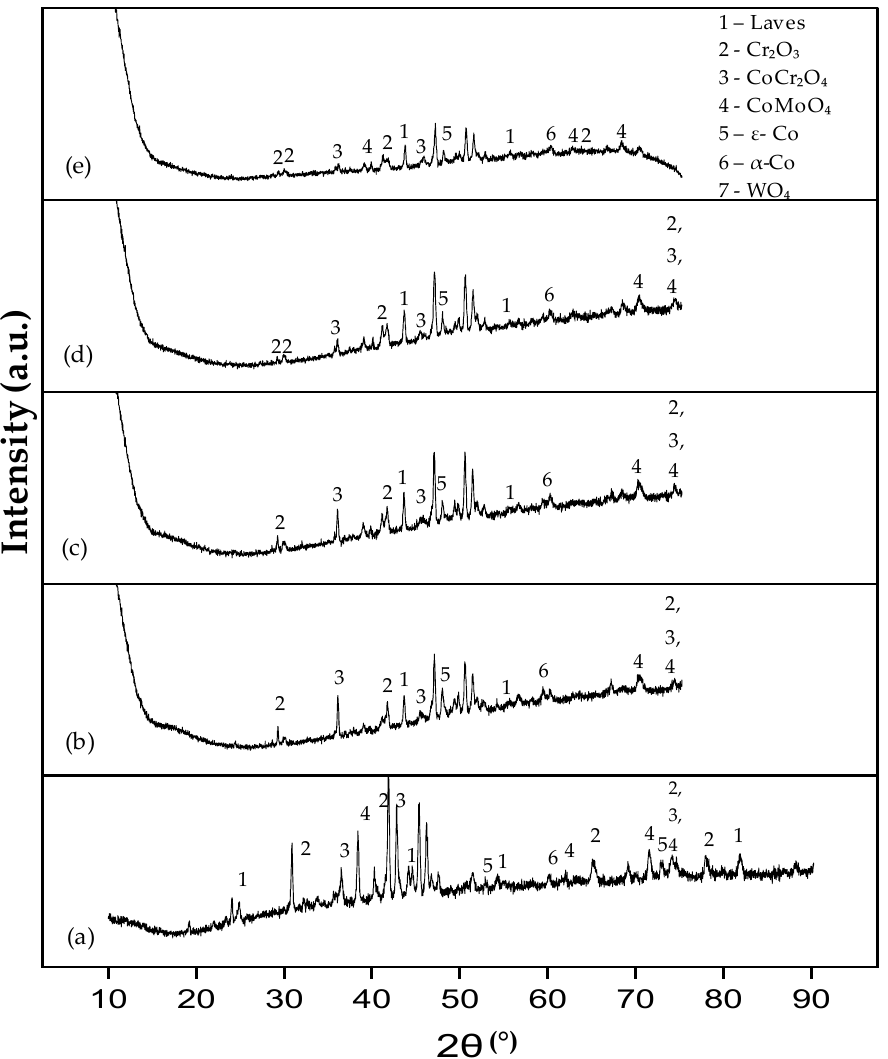
Figure 4. XRD patterns for the T-800/WC oxidised specimen at ( a ) 24, ( b ) 48, ( c ) 72, ( d ) 96 and ( e ) 120 h.